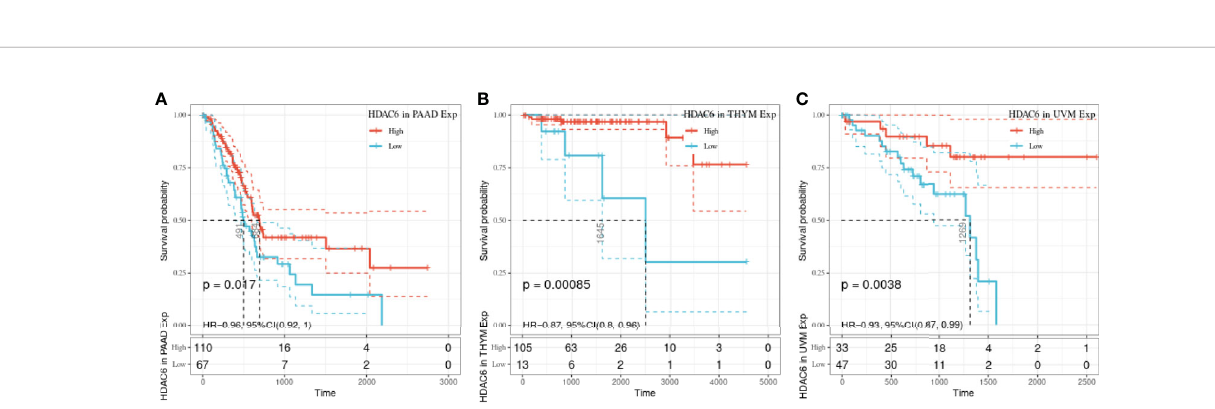
FIGURE 2 | Analysis of the relationship between HDAC6 and OS in 33 tumors using one-way Cox regression, presented using forest